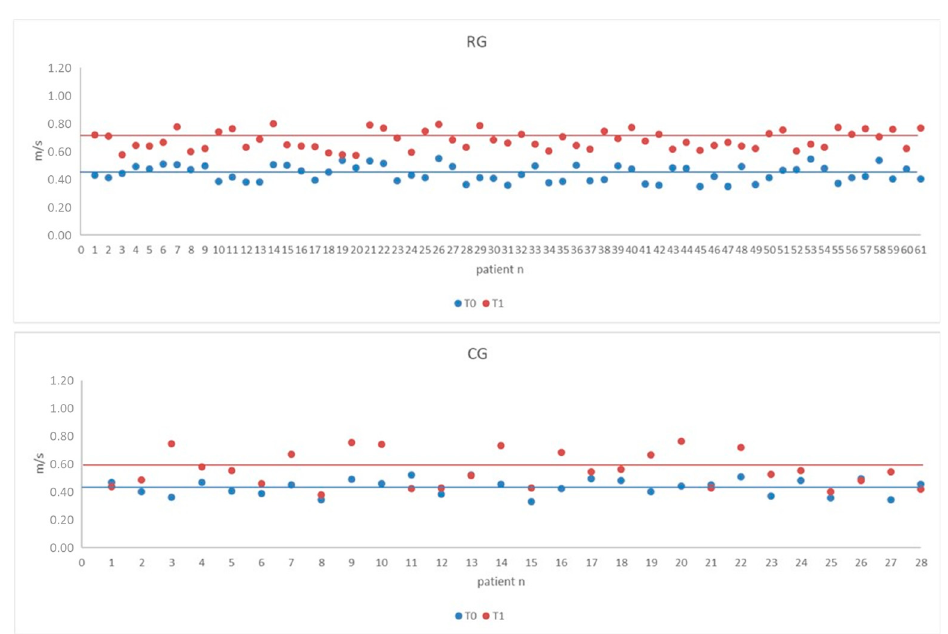
Figure 2. Scatterplot of 10-Meter Walk Test (10 MWT) of the Robotic Group (RG) and Control Group (CG) at baseline (T0) and final (T1) assessments. The horizontal lines within the plot represent the mean value.